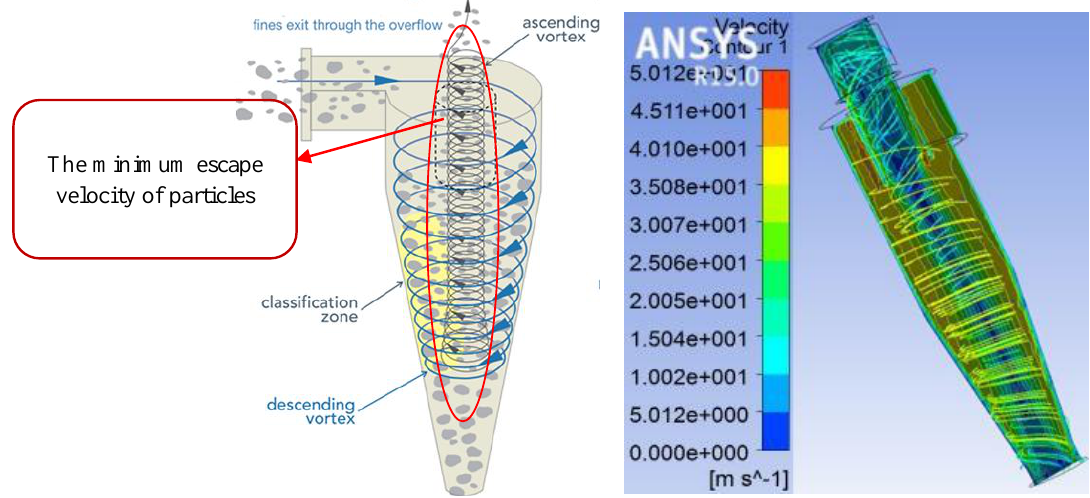
Figure 6. 3D map contours of velocity (m s -1 ) at PE100 with N2 flow rate of 14040 m 3 hr -1 .